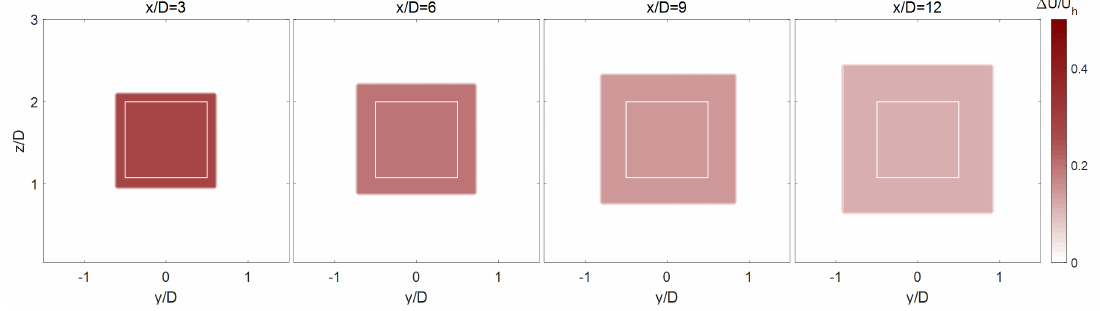
Figure 8. Same as Figure 7 but obtained from the top-hat wake